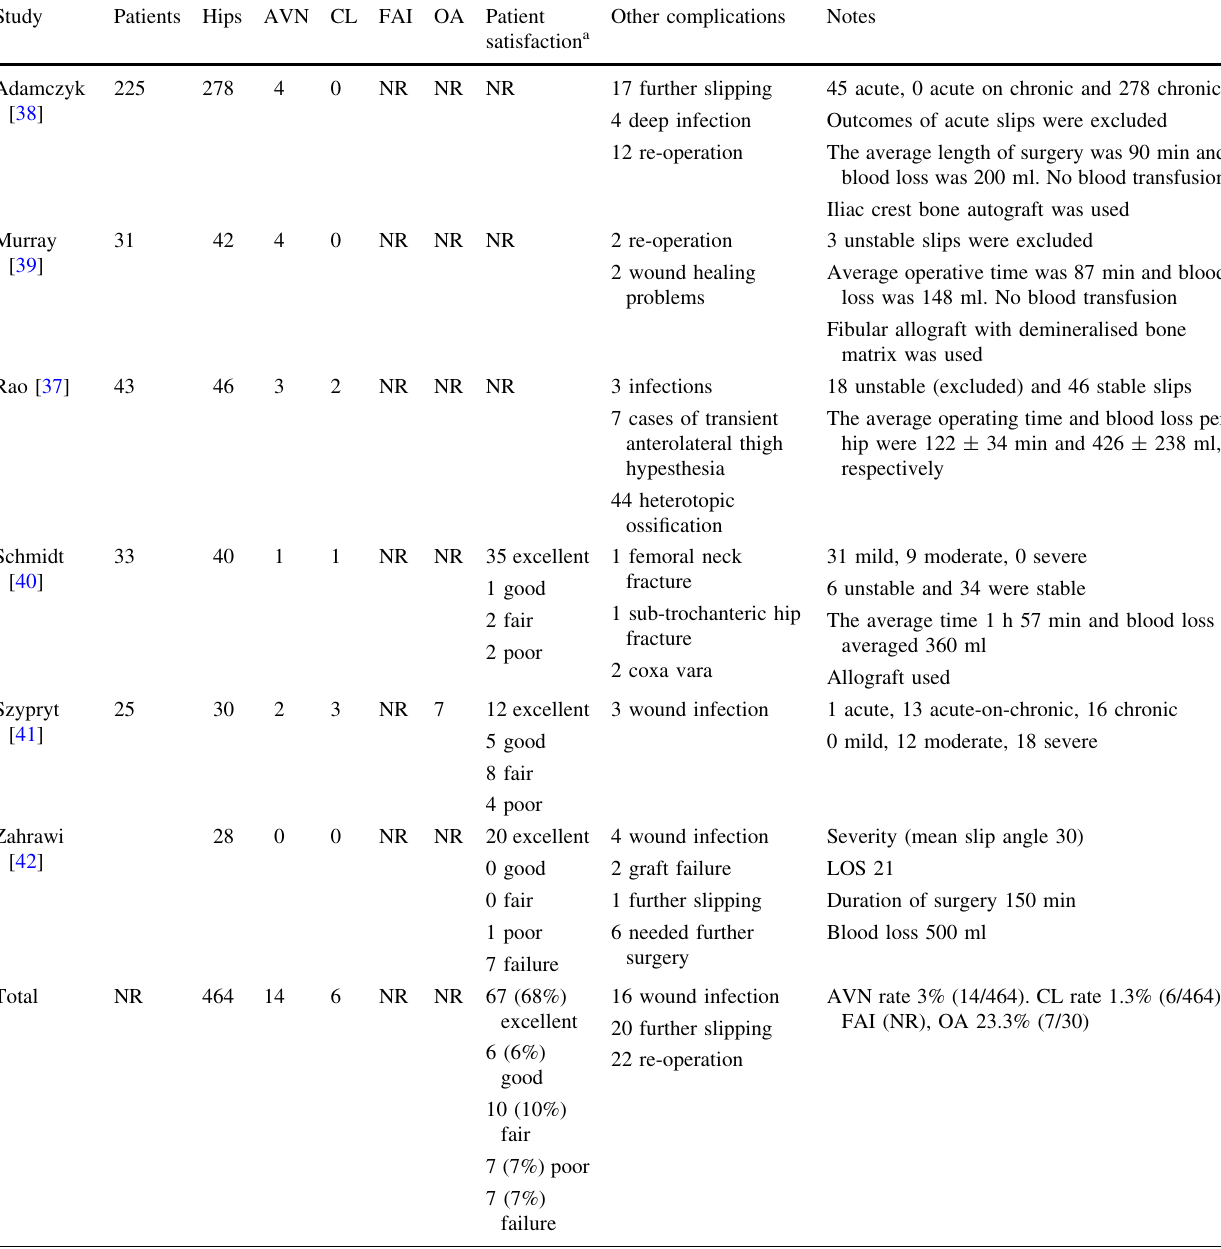
Table 5 Studies of using bone peg epiphysiodesis in stable slips